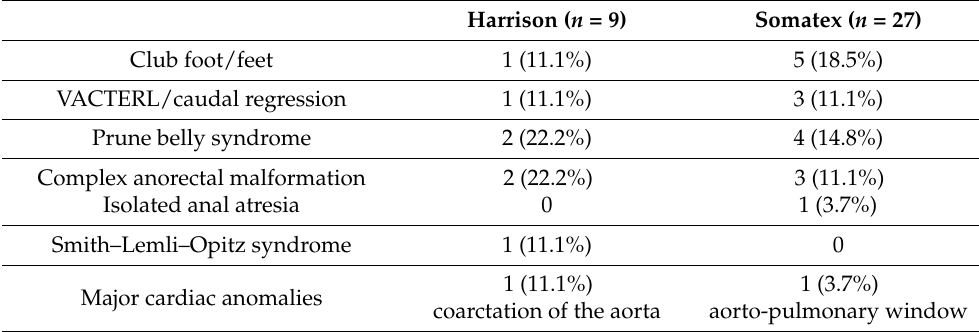
Table 3. Additional malformations in 36